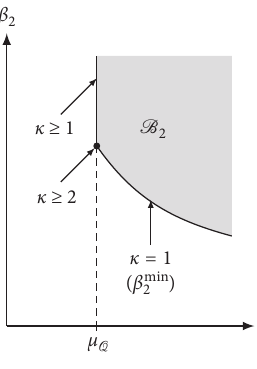
Figure 2: Dimension of kernel κ � dim ( ker ( C )) of difference matrix C on z B for Lemma 2.1 and Lemma 2.2 with μ Q ∈ Λ 2 c � 0,correspondingtoLemma2.3, z B c Q ≠ 0;incaseof Q ( β ) ( κ � 1), which then diverges to + ∞ at β by the curve β min 1 2